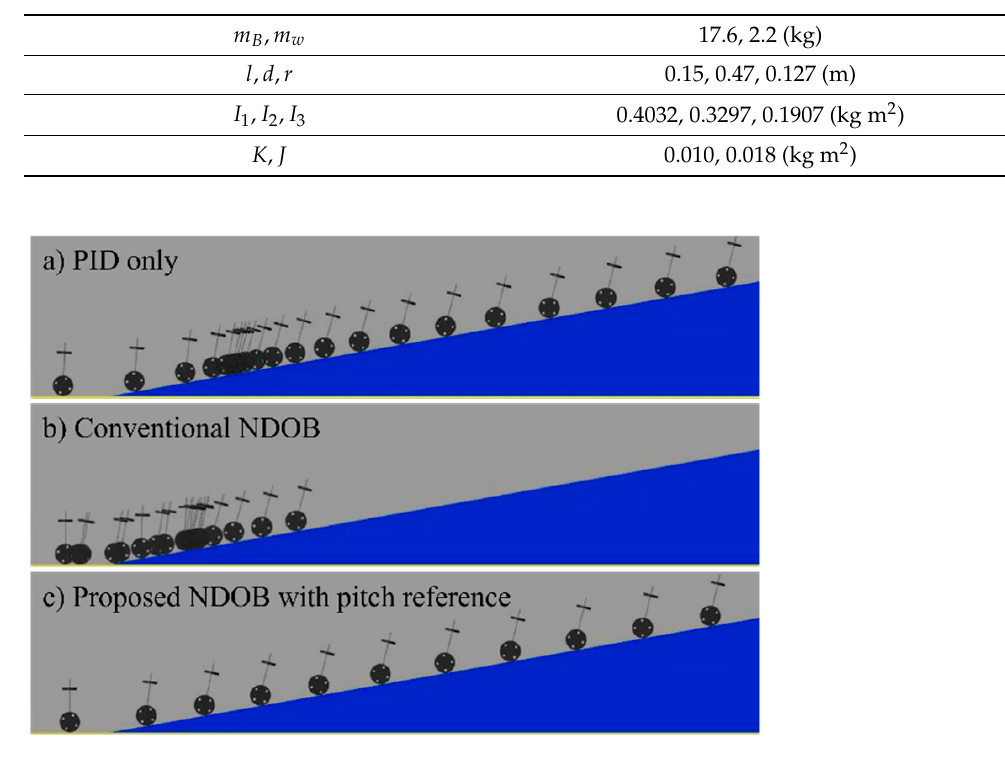
Figure 7. Climbing a ramp with an unknown slope of 10 degrees.